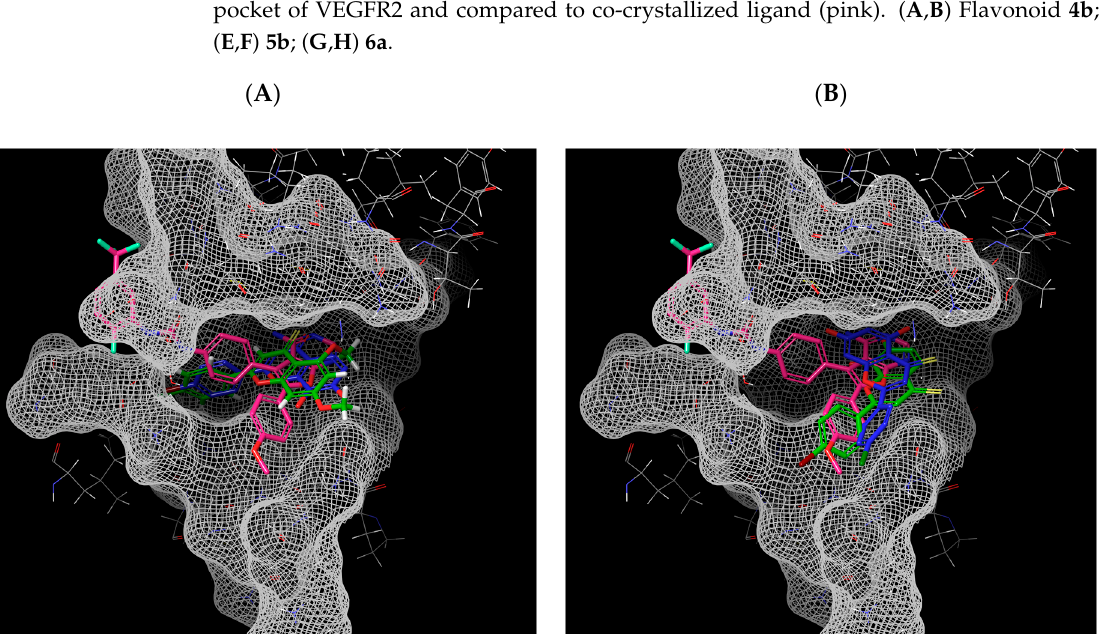
Figure 8. 3D interaction of flavonoid derivatives ( 4b , 5a , b and 6a ) (green) with the ATP-binding pocket of VEGFR2 and compared to co-crystallized ligand (pink). ( A , B ) Flavonoid 4b ; ( C , D ) 5a ; ( E , F ) 5b ; ( G , H ) 6a .